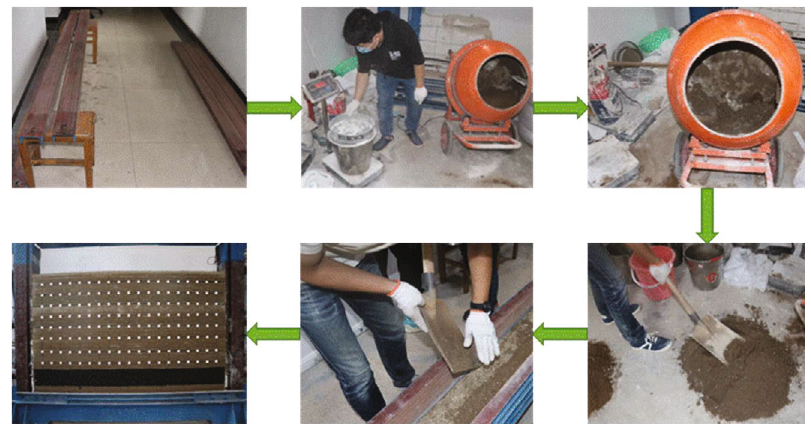
Figure 5: Similar material model laying process.